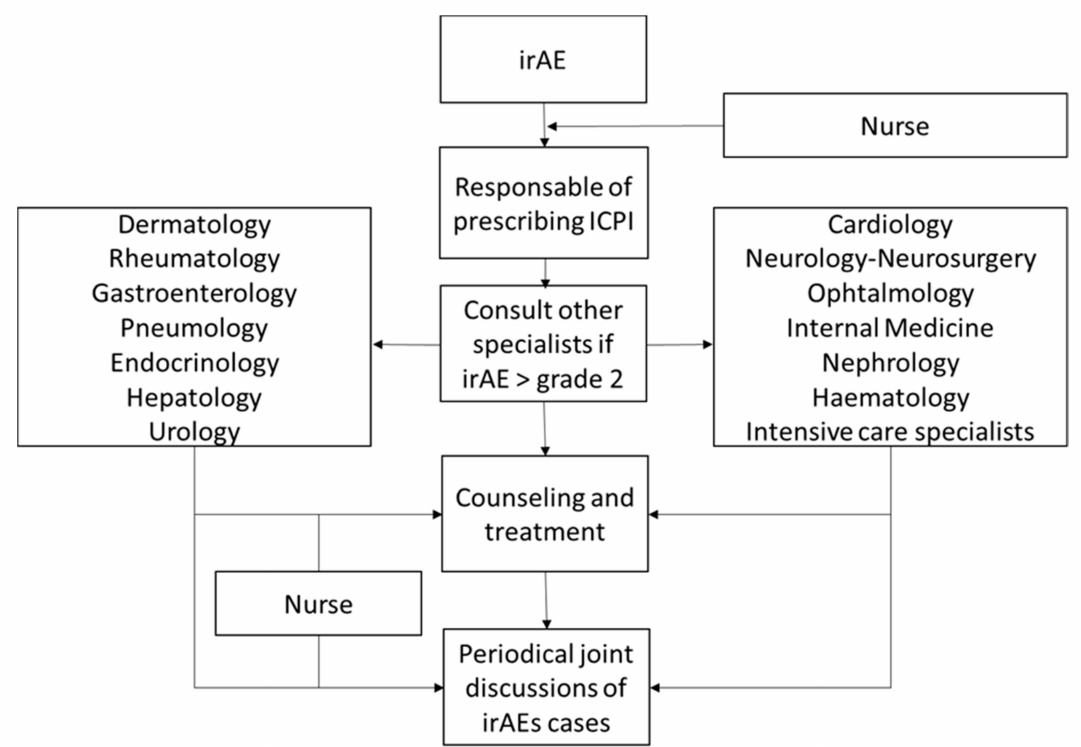
Figure 1. Workflow of the multidisciplinary approach to the management of immune-related adverse events